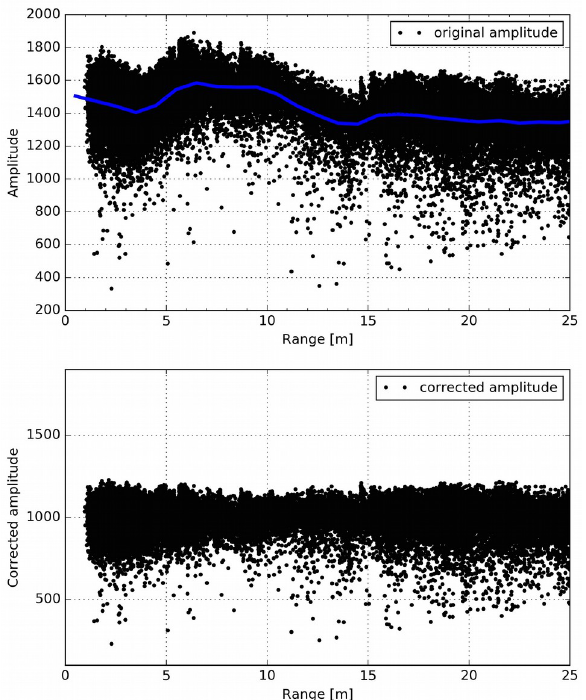
Figure 3. Amplitude correction using range binning and correction by binned means. Top: Original amplitude distribution with bin centres as blue line. Bottom: Corrected amplitude centred at